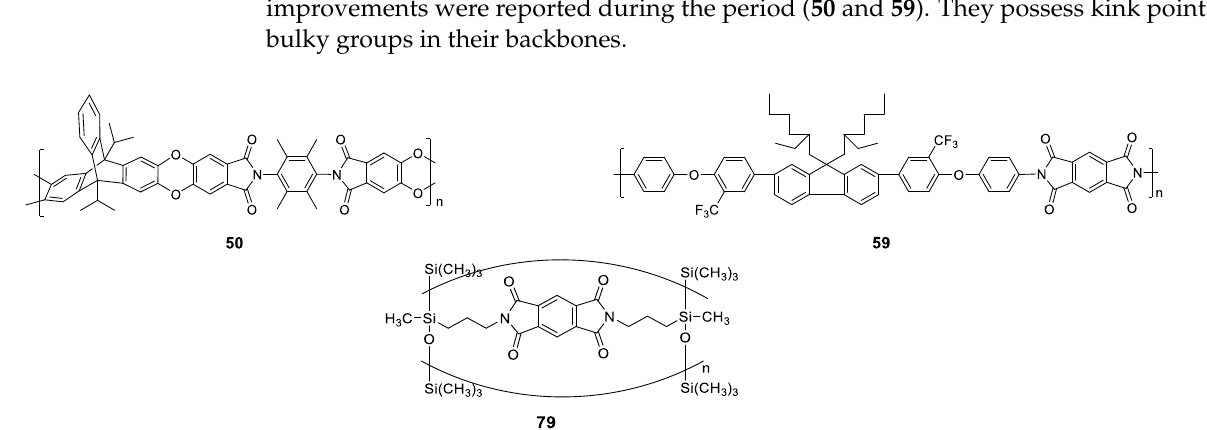
Polymers 2021 , 13 , x FOR PEER REVIEW Chart 6. Chemical structures of the membrane polymers in Figure 9 (PIs in 2020). Table 7. Categorization and detailed data for the membrane polymers in Figure 9 (PIs in 2020). Code